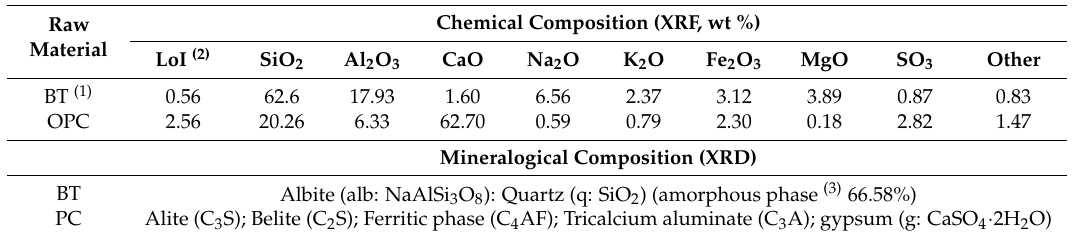
Table 1. Chemical (XRF) and mineralogical (XRD) composition of the starting materials. Raw